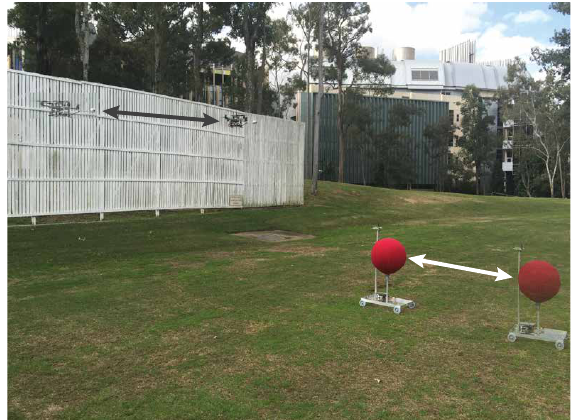
Figure 15. Outdoor experimental configuration for Triangle Closure Method (TCM). Reproduced with permission from